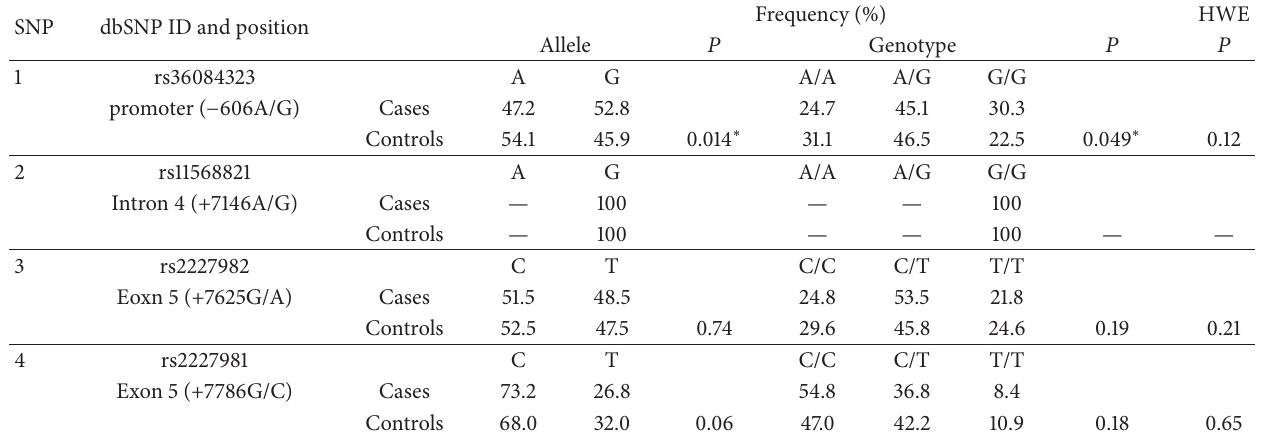
HWE indicates Hardy-Weinberg equilibrium; ∗ 𝑃 < 0.05 . Table 3: The association analysis of rs36084323 with RA (adjusted by sex) by using logistic regression.